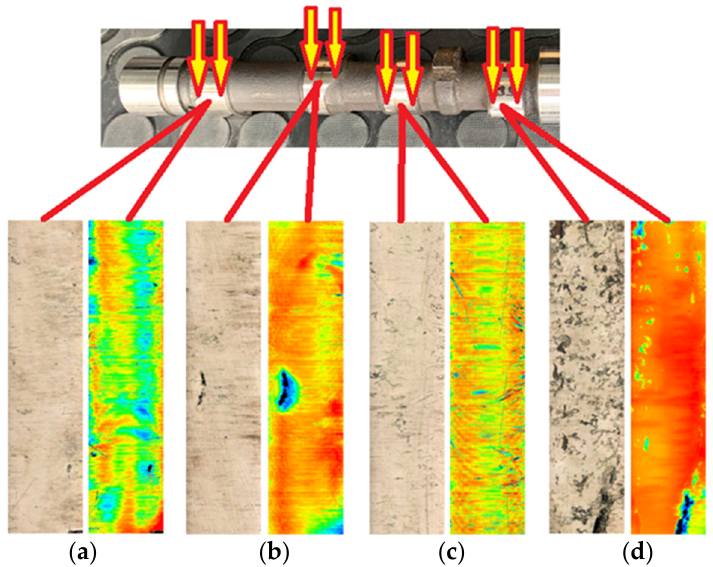
Figure 8. Wear of cam friction surfaces on 1st and 2nd cylinders: ( a ) 1st cylinder intake cam; ( b ) 1st cylinder exhaust cam; ( c ) 2nd cylinder intake cam; ( d ) 2nd cylinder exhaust cam.